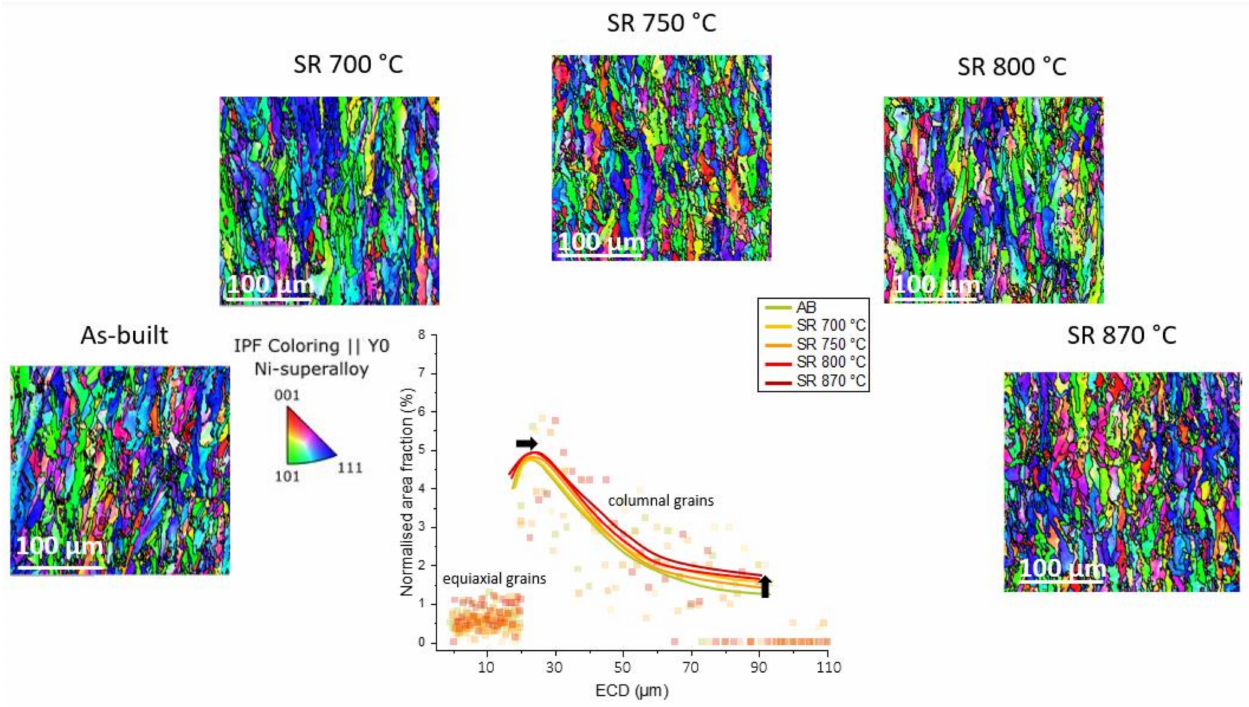
Figure 6. The EBSD orientation maps and grain size distribution before and after different stress- relieving treatments.